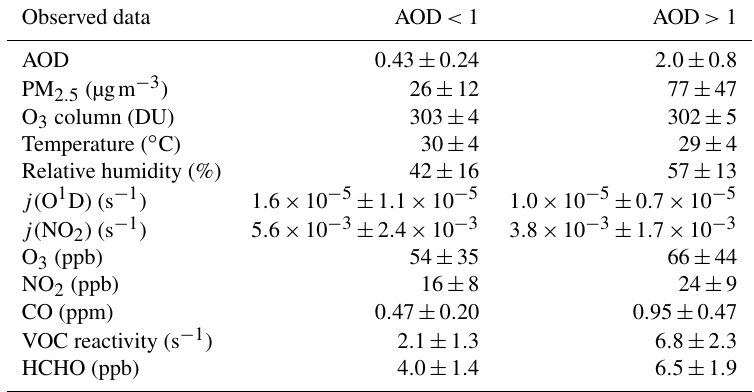
Table 8. Monthly mean and standard deviation of observed data during daytime (06:00–18:00) under the conditions of AOD less than 1 and larger than 1 in August